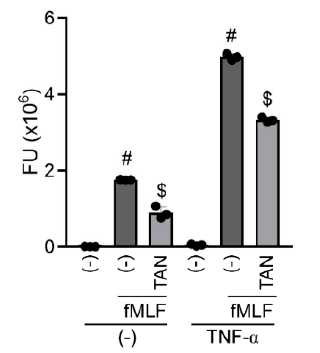
Figure 3. Tanimilast also counteracts elastase release by fMLF in the presence of TNF- α . Human neutrophils were incubated with vehicle ( − ) or tanimilast (TAN) at 10 − 7 M. When indicated, pretreat- ment with TNF- α (20 ng/mL) was also performed. Degranulation was induced by fMLF treatment (2 × 10 − 8 M) in the presence of cytochalasin B. Elastase release was assessed as in Figure 2. Results are expressed as fluorimetric readout (FU, Fluorimetic Unit) of elastase enzymatic activity in the cell supernatants. Percent of inhibition by tanimilast was 56.5 ± 4.5 and 33.5 ± 1.0 in the absence and in the presence of TNF- α priming, respectively. # p < 0.05 One-way ANOVA followed by post hoc test vs. fMLF untreated cells; $ p < 0.05 One-way ANOVA followed by post hoc test vs. fMLF-treated cells. ( n = 3).